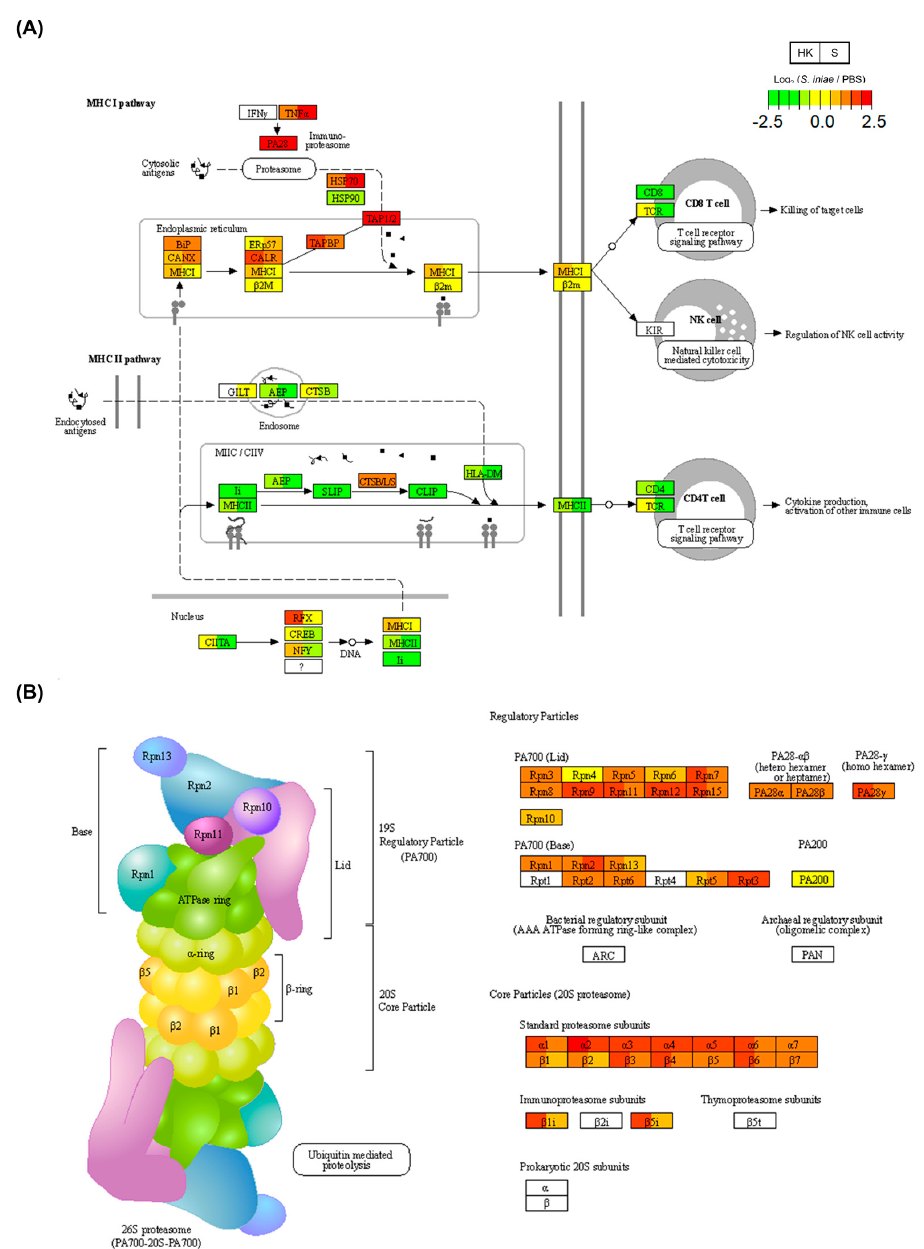
Figure 6. Antigen processing and presentation pathway map in the KEGG. Relative gene expression levels in the Streptococcus iniae -infected and phosphate-buffered saline (PBS)-treated groups are shown in these visualizations of ( A ) antigen processing and presentation (ko04612) and ( B ) proteasome pathways. The gene expression levels across four groups (K: kidney; S: spleen; 1: 1 day post-infection (dpi); 2: 2 dpi) are shown in each gene box. The lower expression levels of genes are shown in green, and the higher expression levels of genes are shown in red. Undetected genes are shown in white (see color legend in figure).